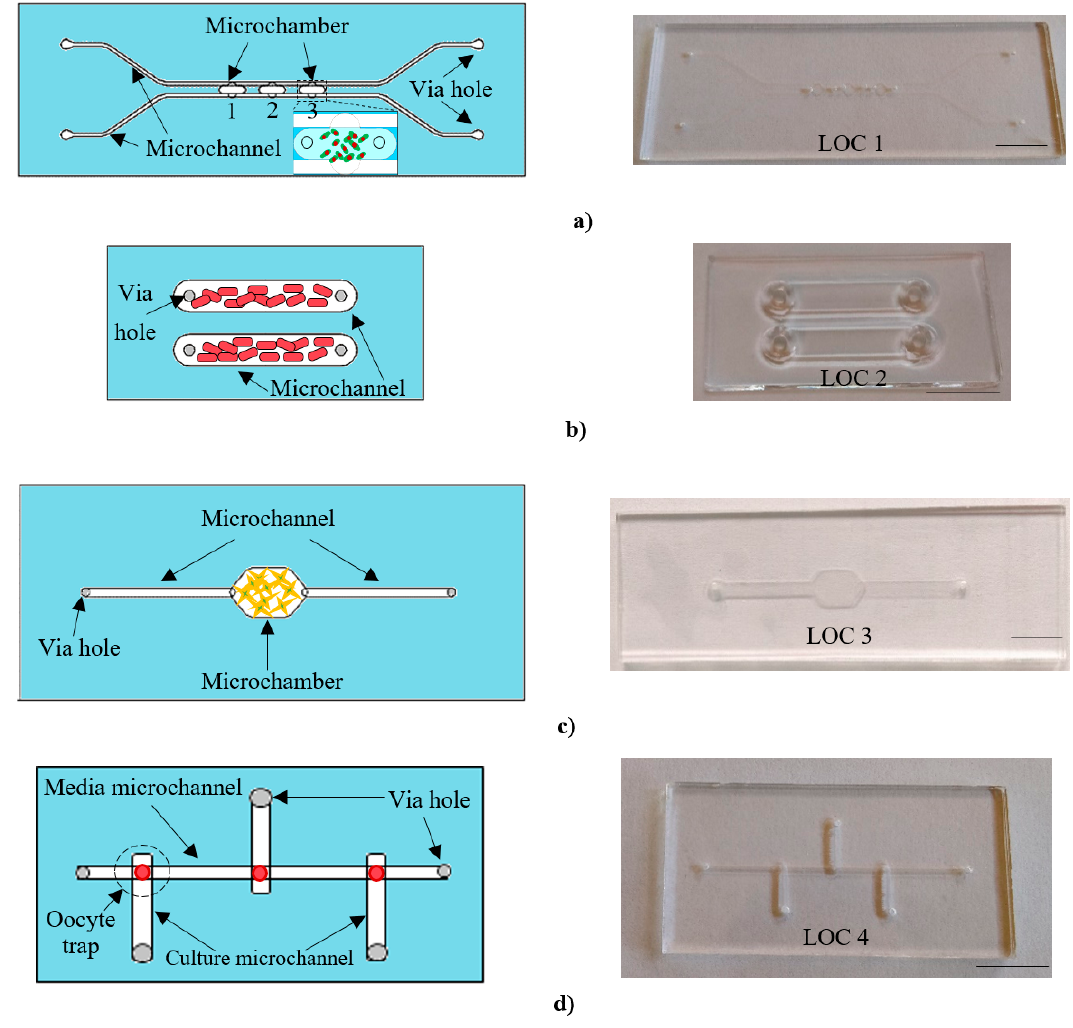
Figure 2. A family of all-glass lab-chips dedicated to cell culturing of various biological objects: ( a ) freshwater micro-organisms— Euglena gracilis (volume of the single microchamber: ~1 µ L, surface area: 4 × 2.5 mm 2 ), ( b ) mushrooms— Cladosporium macrocarpum (volume of the microchannel: ~23.5 µ L, surface area: 16.8 × 3.5 mm 2 ), ( c ) human cancer cells SKOV-3 (volume of the microchamber: ~8.5 µ L, surface area: 9.5 × 6 mm 2 ), ( d ) porcine oocytes (volume of the culture microchannel: ~0.6 µ L, surface area: 7 × 0.5 mm 2 ). Scale bar—1 cm. Table 1. Summary of geometrical specification for each lab-on-chip (LOC).